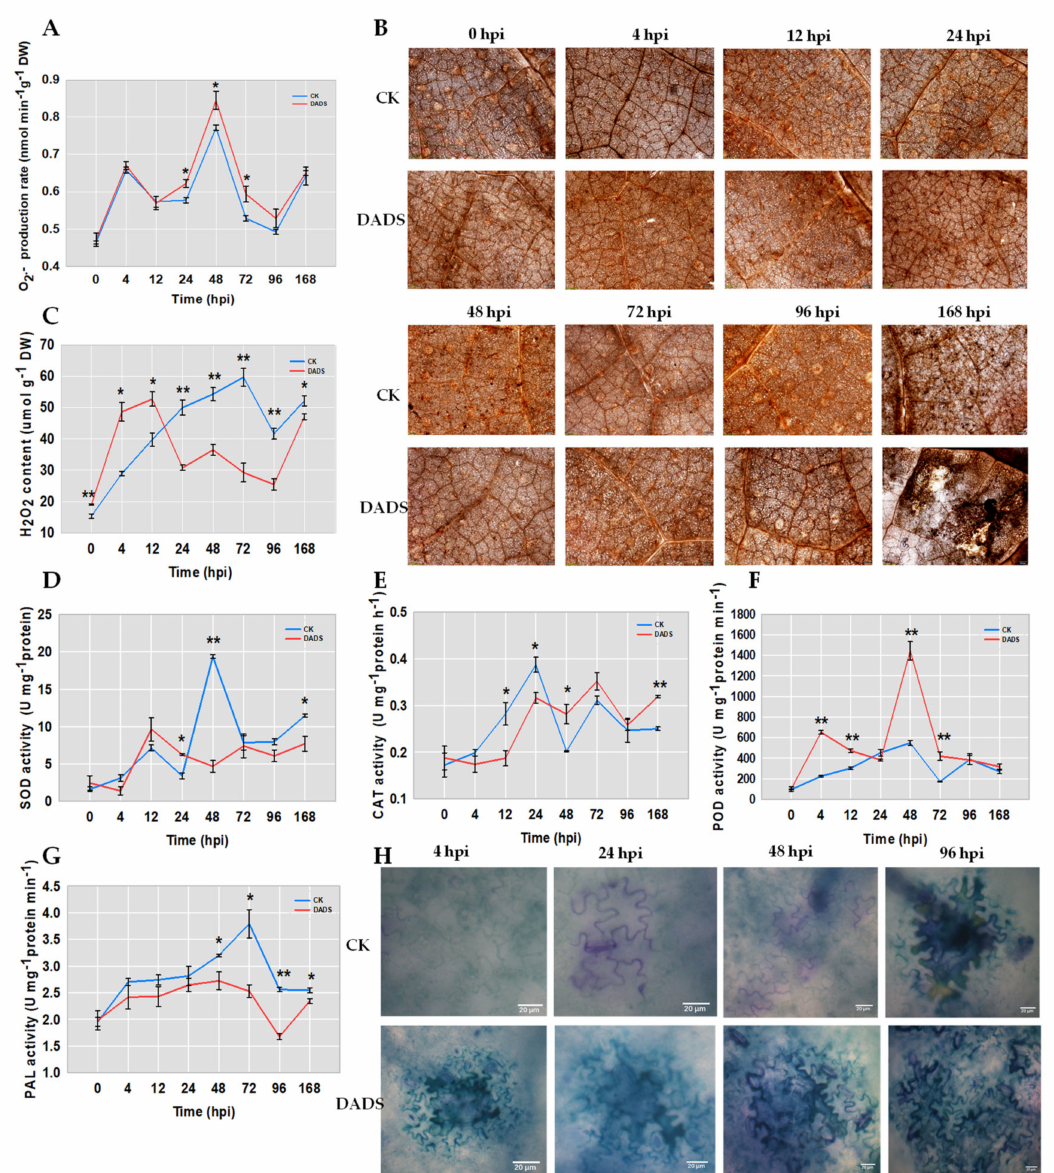
Figure 2. Comparison of ROS ( A – C ), defense enzyme ( D – G ), and lignin ( H ) in DADS-treated and CK cucumber leaves with P. cubensis infection. ( B ) Histological observation of H 2 O 2 by DAB dyed. ( H ) Histological observation of lignin by TB dyed. Data are means ± standard errors (n = 3, three biological replicates). Asterisks indicate significant differences between the DADS treatment and CK (* p < 0.05; ** p < 0.01) based on a one-way ANOVA followed by a t − test. Scale bars: 200 µ m ( B ), 100 µ m ( H